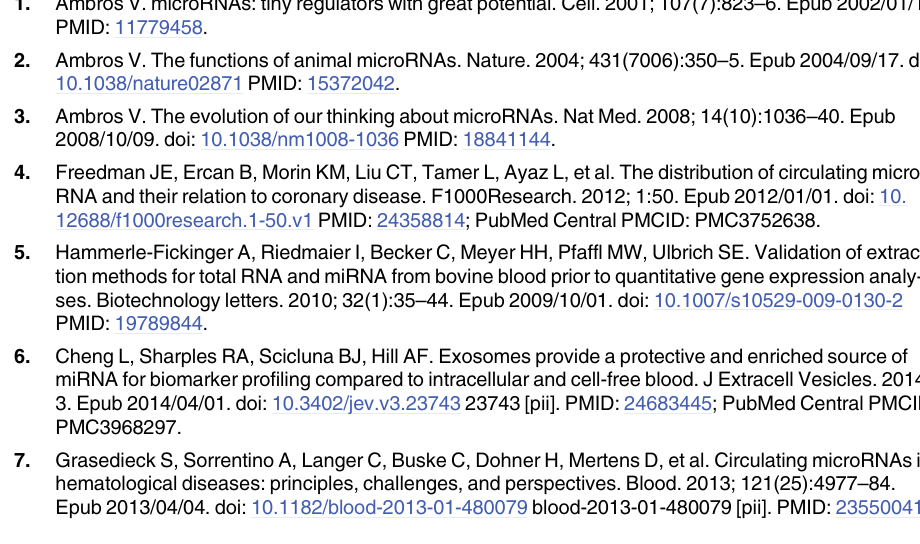
S1 Table. Summary characteristics of 153 miRNAs assayed in whole blood and plasma in FHS participants. The numbers of subjects in this table (N) correspond to the number of sub- jects with measured values for each miRNA in blood or plasma (but do not indicate the num- ber of subjects in